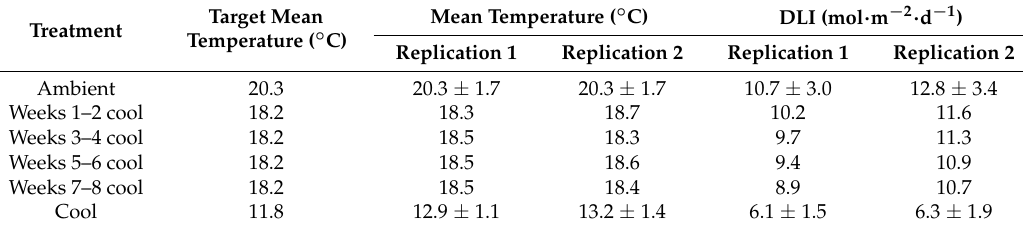
Table 1. Mean air temperature ( ◦ C) and daily light integral (DLI, mol · m − 2 · d − 1 ) for each treatment. Plants were grown in ambient conditions [22/18 ◦ C air temperature, 14 h photoperiod, and